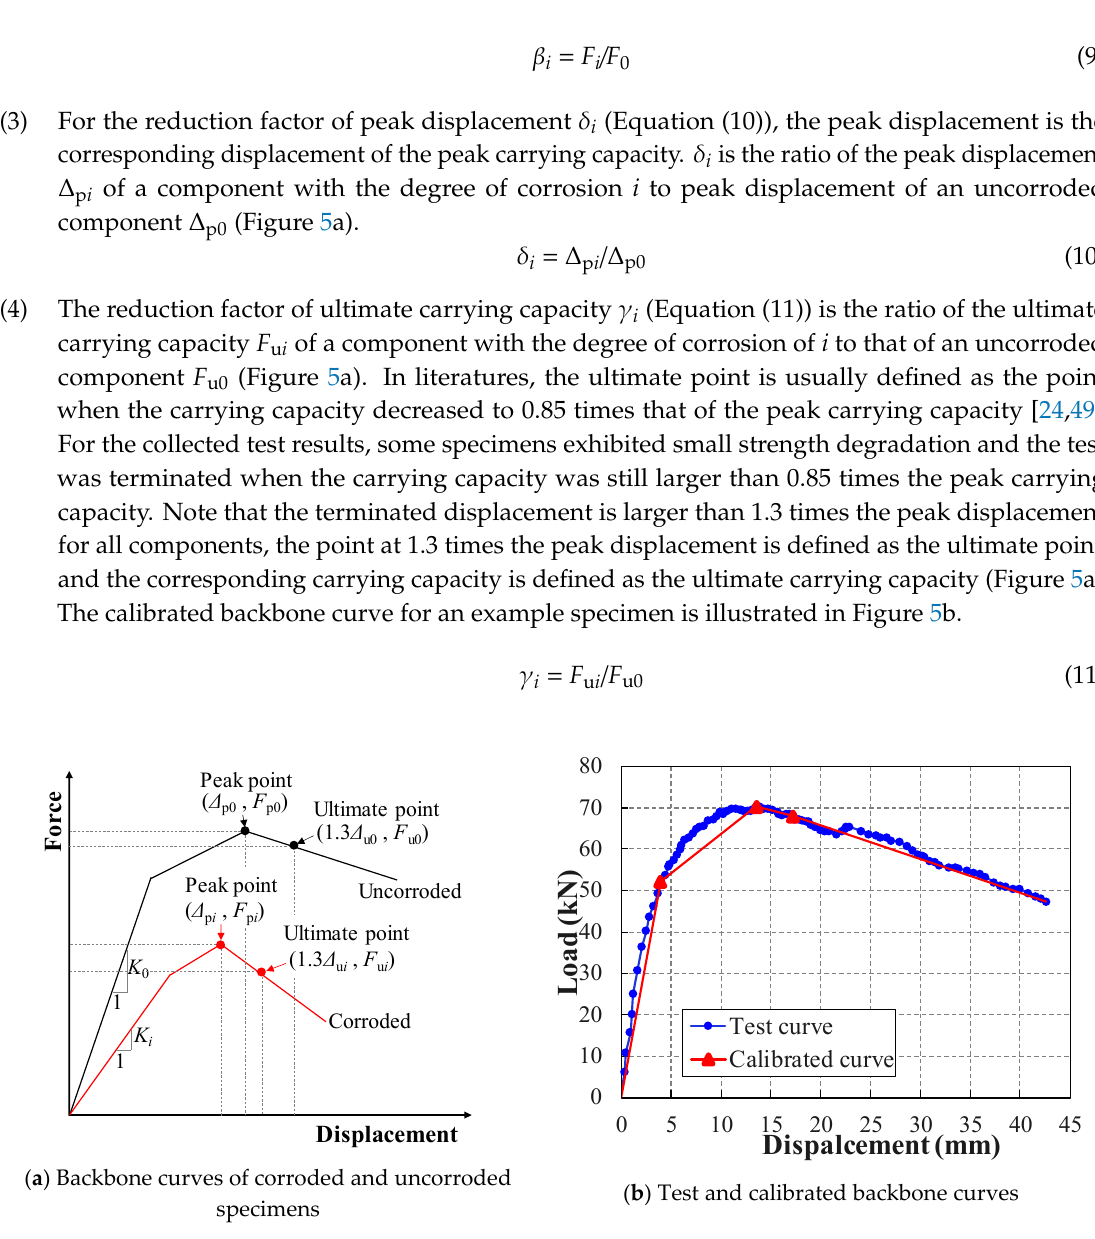
Figure 5. Calibration of backbone curve parameters: ( a ) Backbone curves of corroded and uncorroded specimens; ( b ) Test and calibrated backbone